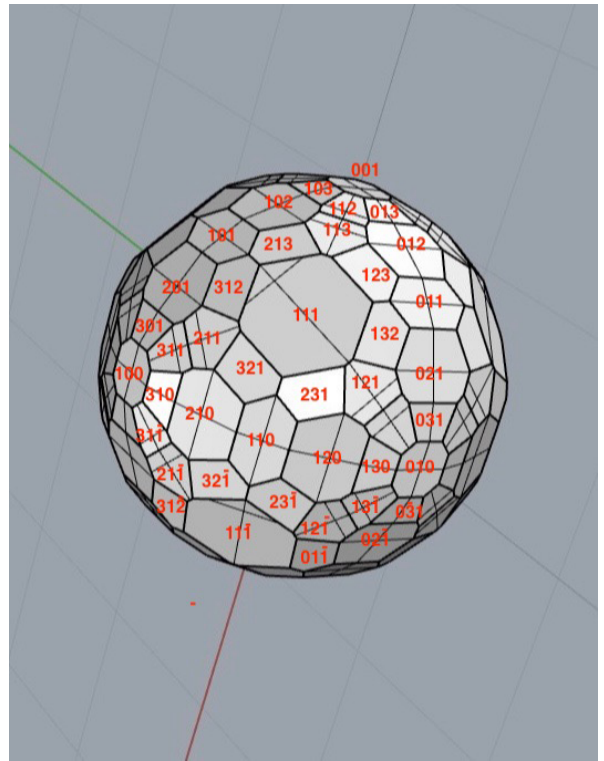
Figure 9. A 3D digital model. Miller indexes were printed on the